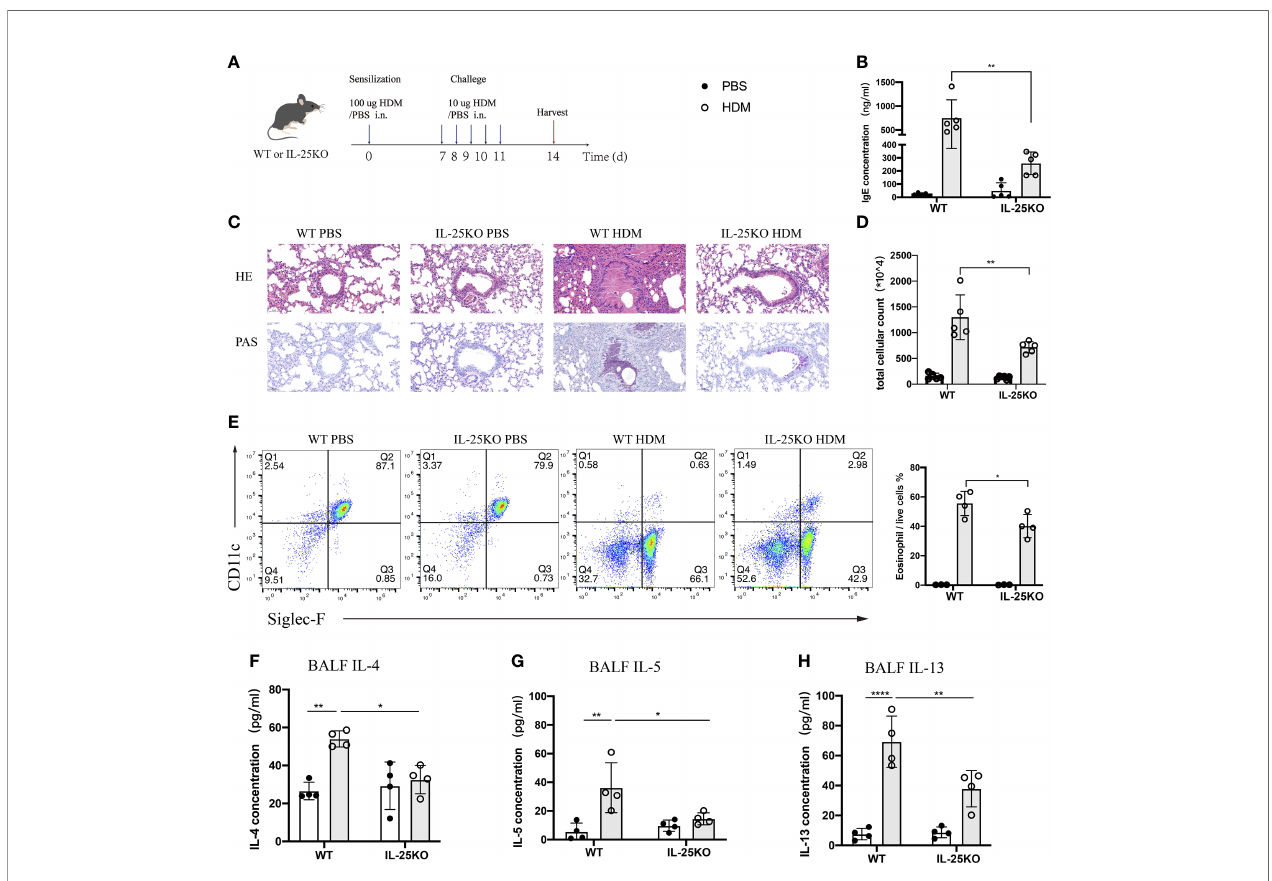
FIGURE 3 | IL-25 de fi ciency ameliorates HDM-induced airway in fl ammation. (A) Schematic representation of house dust mite (HDM)-induced allergic airway in fl ammation of wild-type and global IL-25 -/- mice. (B) Serum IgE level after HDM or PBS challenge. (C) HE&PAS lung histology images of wild-type and global IL- 25 -/- mice after PBS or HDM challenge. Scale bars: 50 m m. (D) Absolute cellularity of total cells in BALF of mice in (A) . (E) Flow cytometry analyzed the percentages of BALF eosinophils (CD45 + SiglecF + CD11c - ) in fi ltration into airways after HDM or PBS challenge. (F – H) BALF IL-4 (F) , IL-5 (G) , and IL-13 (H) cytokine